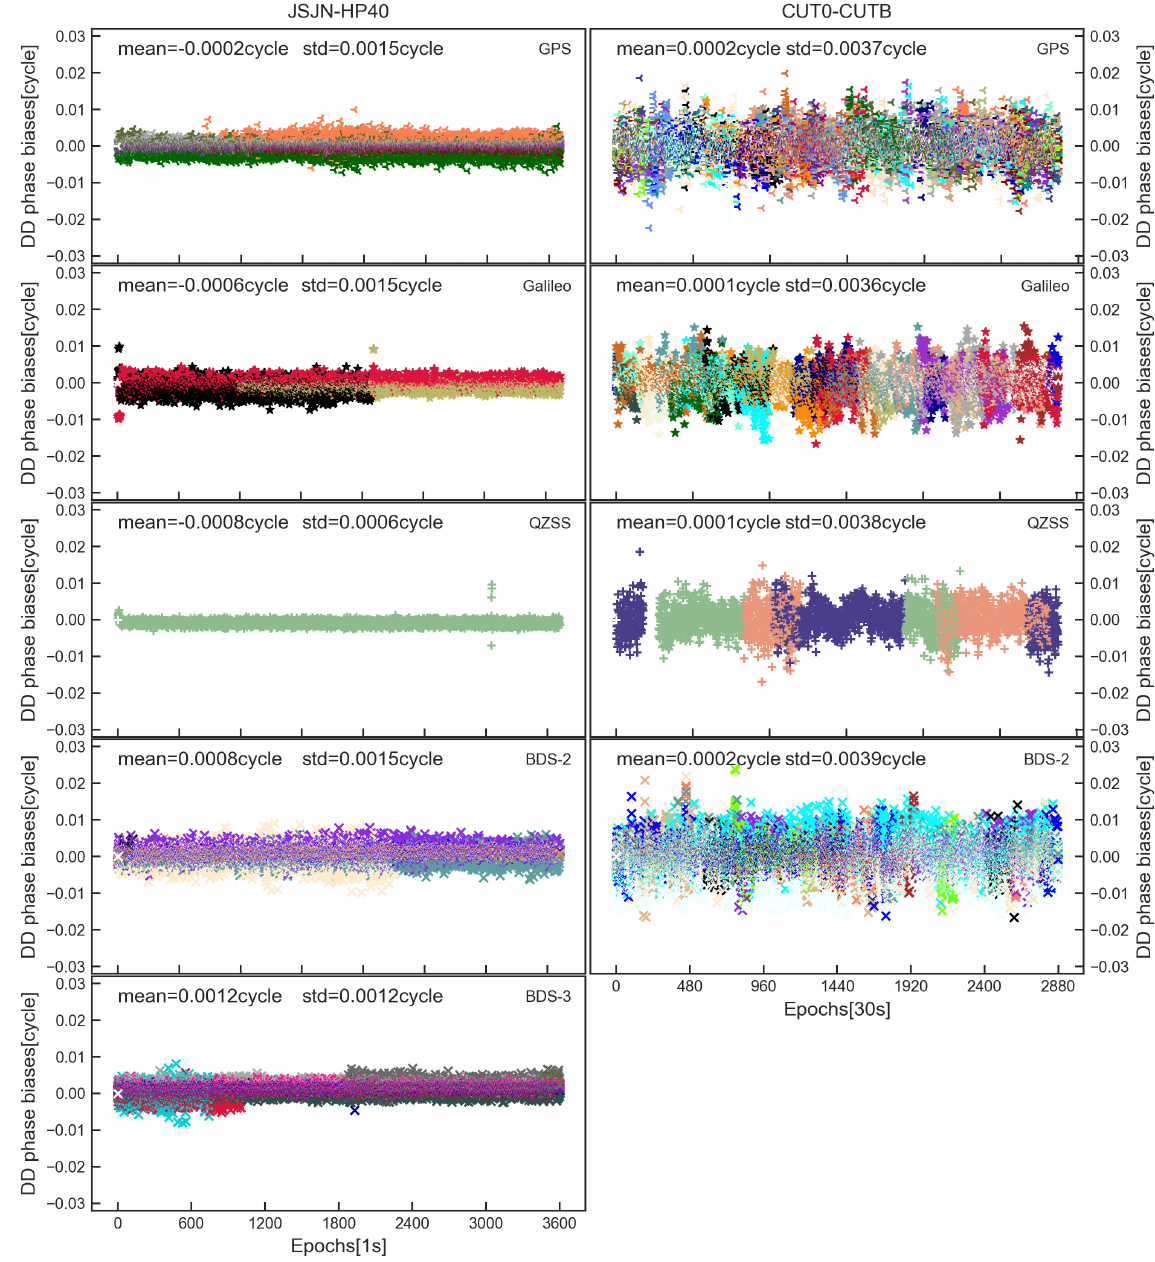
Figure 3. The DD receiver channel − dependent phase bias (cycle) of different systems and satellites for JSJN − HP40 and CUT0 −